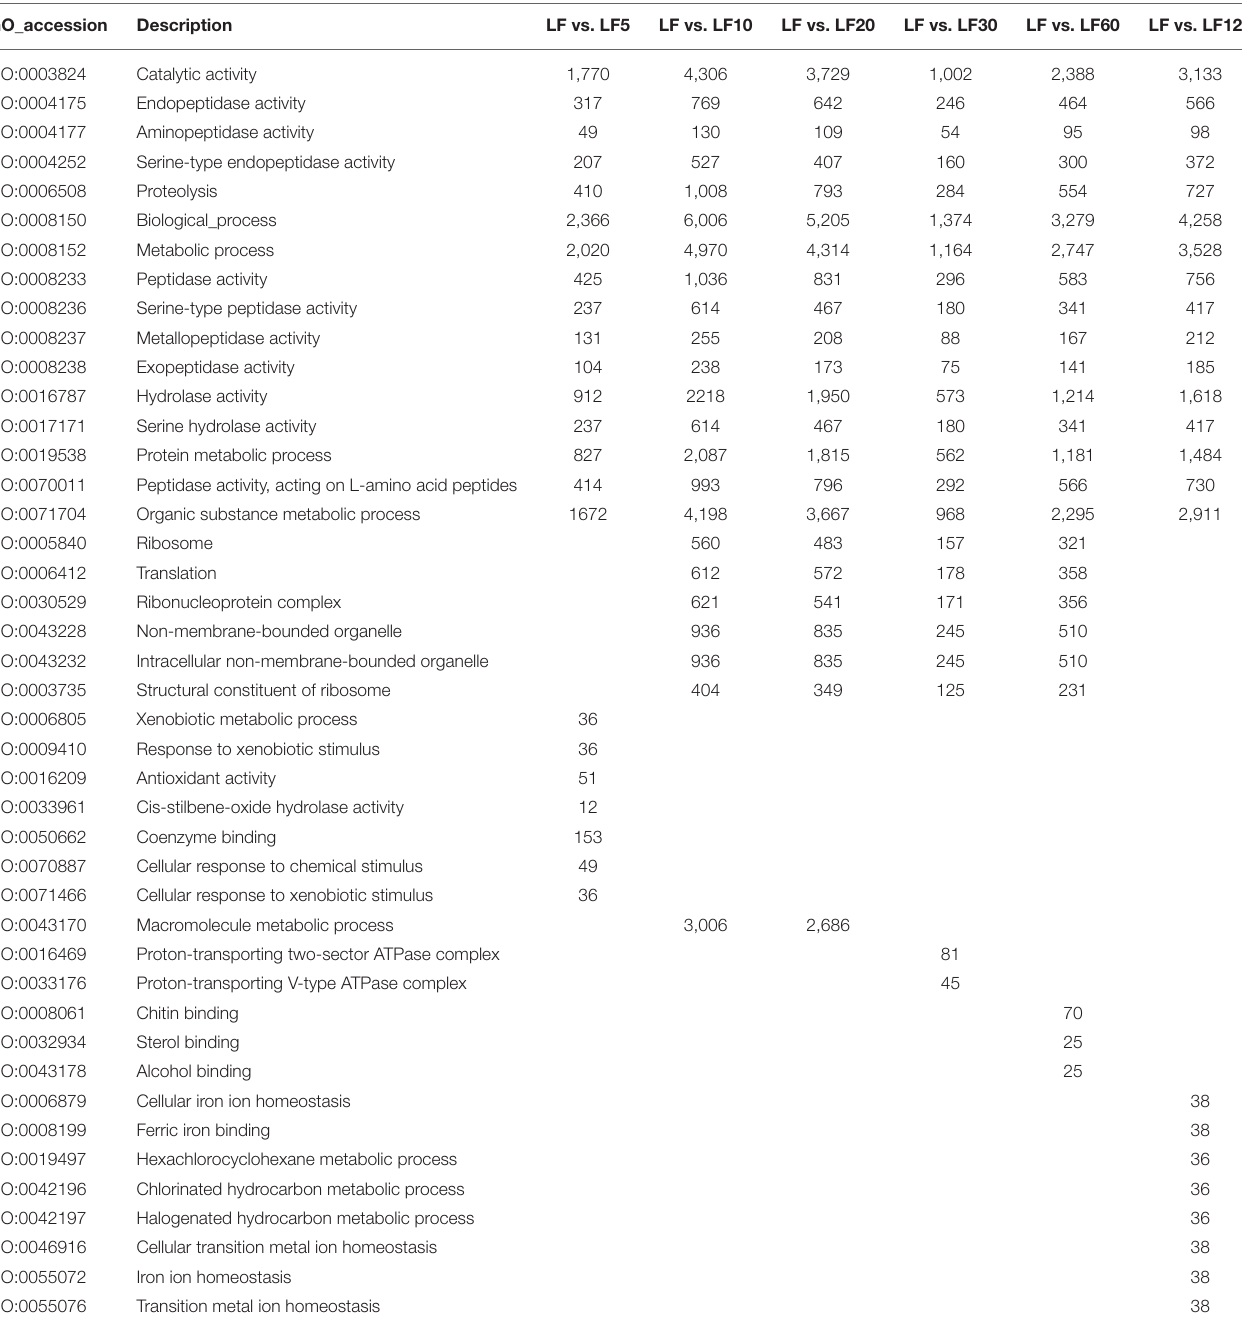
TABLE 3 | Gene ontology (GO) classification of differentially expressed genes in susceptible and resistant strains. Description LF vs. LF5 LF vs. LF10 LF vs. LF20 LF vs. LF30 LF vs. LF60 LF vs.